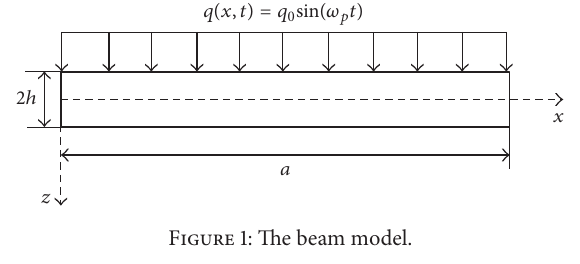
Figure 1: The beam